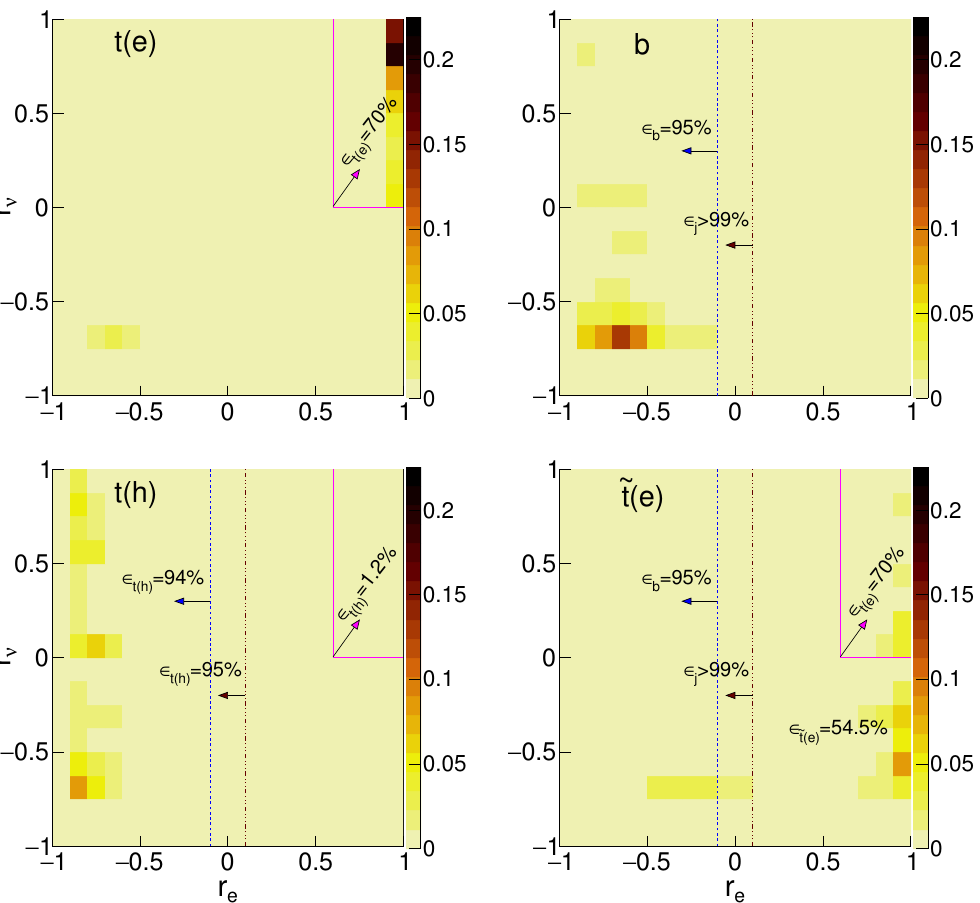
Figure 6 . Probability distribution of BDT responses over a 2-D plane for various event